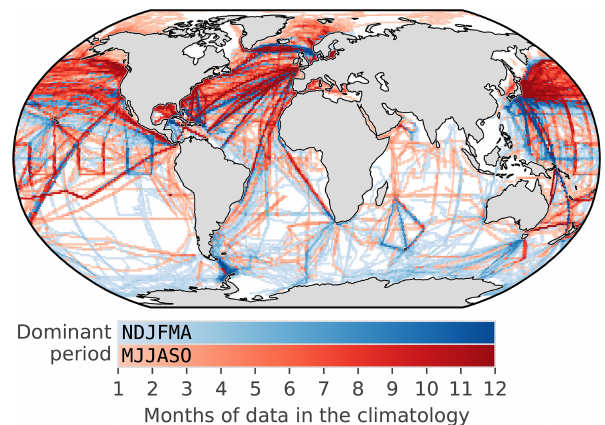
Figure 2. Map showing the distribution of the SOCAT v5 monthly gridded product (1982–2016) as a monthly climatology to show how well the seasonal cycle is represented (regardless of the year). The red shading shows grid points where the majority of data occur from May to October, and the blue shading shows grid points where the majority of data occur from November to